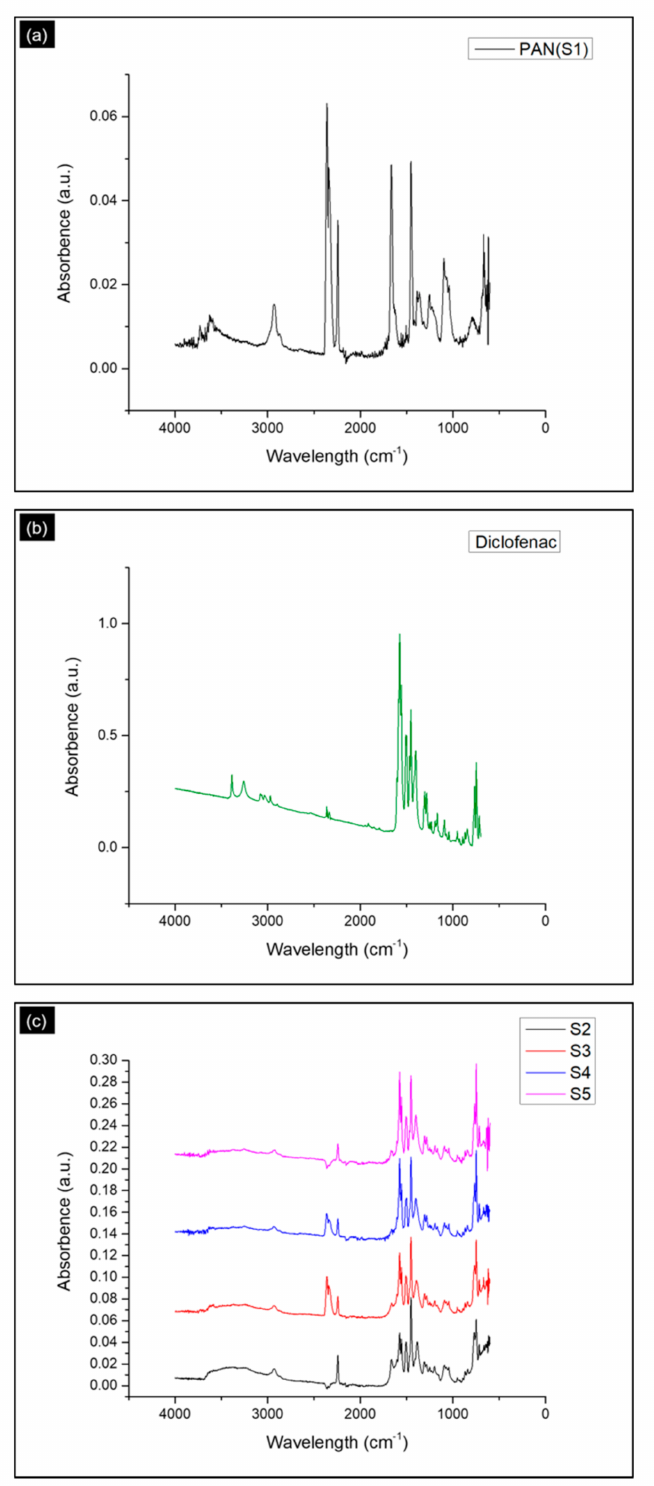
Figure 3. ATR-FTIR spectrum of ( a ) virgin PAN (S1), ( b ) Diclofenac sodium salt and ( c ) DLF loaded PAN nanofibers (S2, S3, S4, and